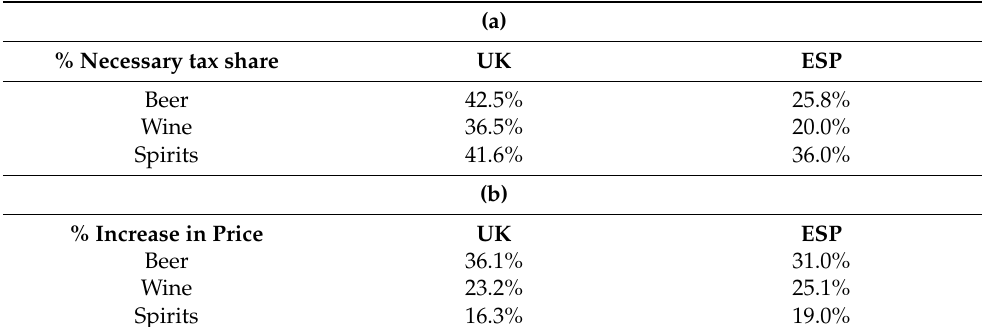
Table A6. ( a ) Tax share necessary to achieve the effect of a 5% decrease in consumption. ( b ) Resulting increase in